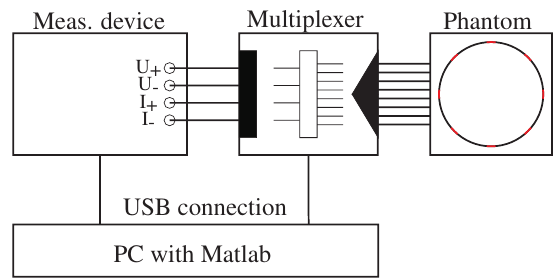
Fig.6: Measurement system schematics with Agilent E4980 impedance measurement device, custom built multiplexer and phantom. A PC is used to control injection frequency and selec- tion of current injection and voltage measurement